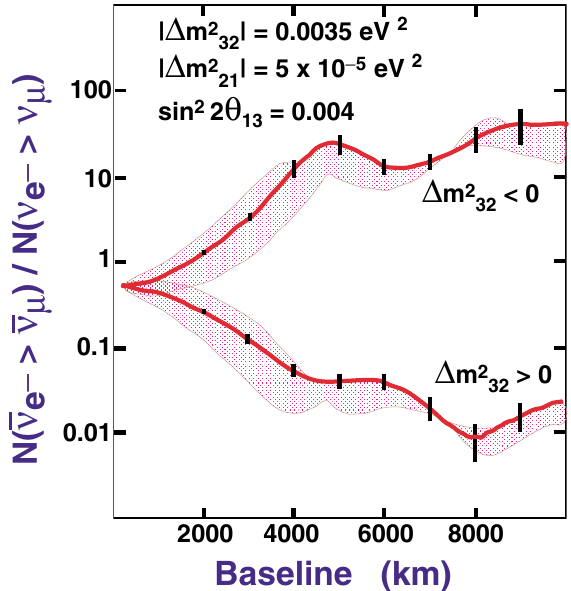
FIG. 6. (Color) Predicted ratios of wrong-sign muon event rates when positive and negative muons are stored in a 20 GeV neutrino factory, shown as a function of baseline. A muon measurement threshold of 4 GeV is assumed. The lower and upper bands correspond, respectively, to negative and . The widths of the bands show how the predic- positive (cid:6)m 2 32 tions vary as the CP -violating phase (cid:6) is varied from (cid:1) (cid:14)= 2 to (cid:14)= 2 , with the thick lines showing the predictions for (cid:6) (cid:4) 0 . The statistical error bars correspond to a high-performance neutrino factory yielding a data sample of 10 21 decays with a 50 kt detector. The curves are based on calculations presented in